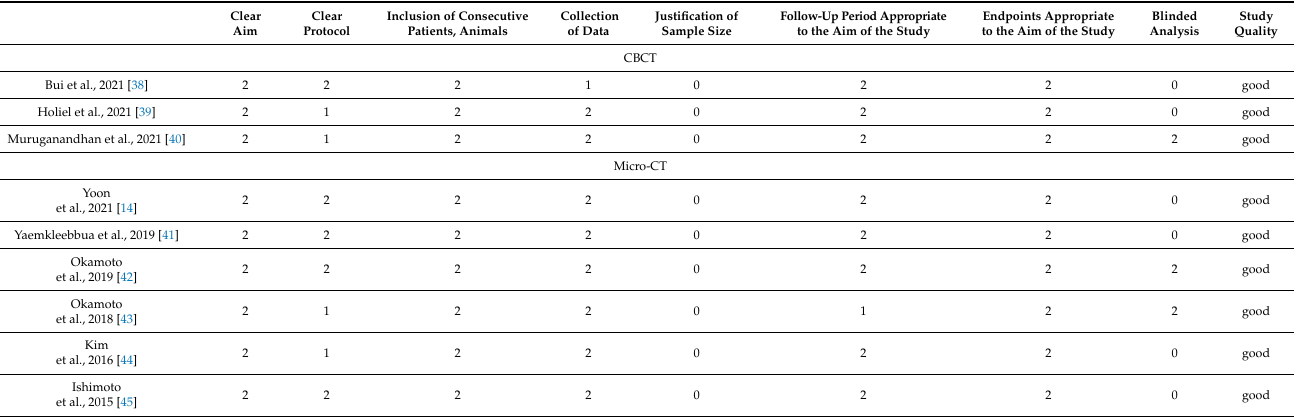
Table 4. Risk of bias according to the MINORS scale in vivo studies (modified methodological index for nonrandomized